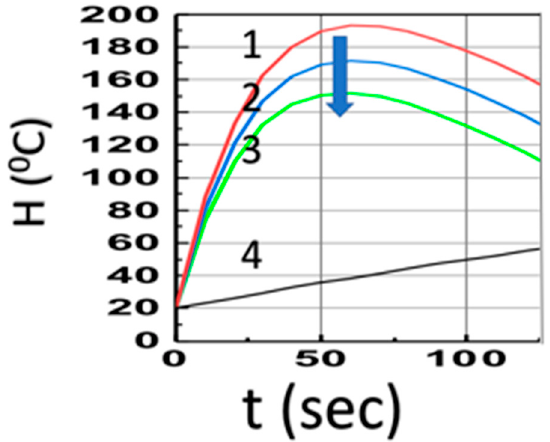
Figure 3. Same as Figure 2, but in the presence of co-initiators, [A] and [B], with aFI 0 = (0, 0.5, 1.0, 1.5) (1/s), for Curves 1, 2, 3 (with bI 0 = 10) and Curve-4 in the absence of PI (with b = 0). The arrow indicates the direction of increased values of aFI 0.